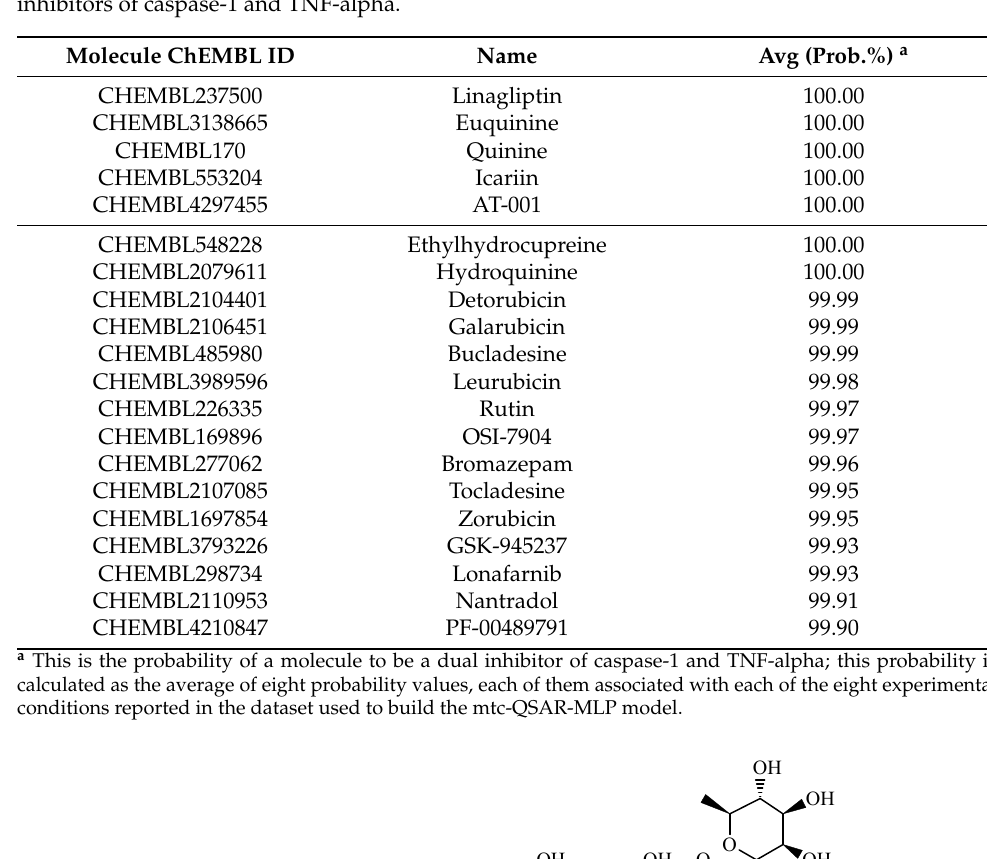
Table 5. Top 20 ranked agency-regulatory chemicals predicted by the mtc-QSAR-MLP model as dual inhibitors of caspase-1 and TNF-alpha.